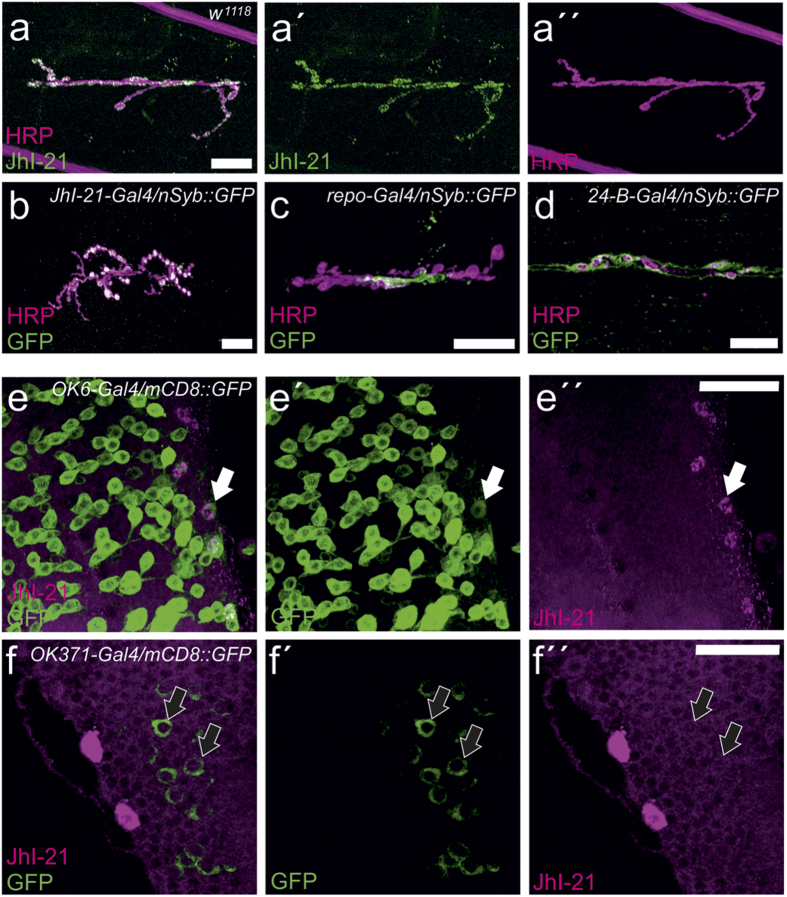
JhI-21 is expressed in presynaptic motor nerve terminals.(a) Confocal image of third-instar larval NMJ formed on ventral longitudinal muscles 6 and 7 marked by anti-HRP (magenta) co-stained with antibodies against JhI-21 (green). (b–d), Representative confocal projections of third-instar larval NMJs formed on ventral longitudinal muscles 6 and 7, stained with antibodies against HRP (magenta) and against GFP (green). Only JhI-21-Gal4 driven transgenic synapse-tethered GFP (nSyb::GFP) expression co-localizes with anti-HRP labeling (B). Glial (repo)-Gal4 or muscle (24-B)-Gal4 driven nSyb::GFP does not show co-localization with anti-HRP labeled motor-neurons. (e,f) Ventral nerve cord (VNC) of third instar larva. (E) Cell bodies of motor-neurons marked by OK6-Gal4 driving the expression of membrane bound mCD8GFP (green), and are co-labeled by anti-JhI-21 (magenta). (F) Cell bodies of glutamatergic neurons marked by OK371-Gal4 driving the expression of membrane bound mCD8GFP (green), and are co-labeled by anti-JhI-21 (magenta). Two arrowheads are pointing two examples of cells expressing both the GFP marker and JhI-21. Scale Bar NMJ = 20 mm. Scale Bar VNC = 40 μm.